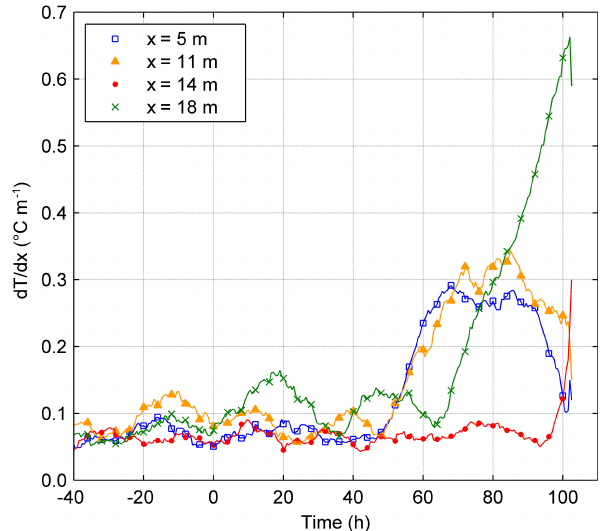
Figure 9. Temperature gradients along the most downstream line F1 at some significant points: at x = 5, x = 11 and x = 18m sand boils were observed; also at x = 18m likely preferential seepage path at the contact with the foil; at x = 14m no traces of piping (until 90h when visual inspection was suspended).